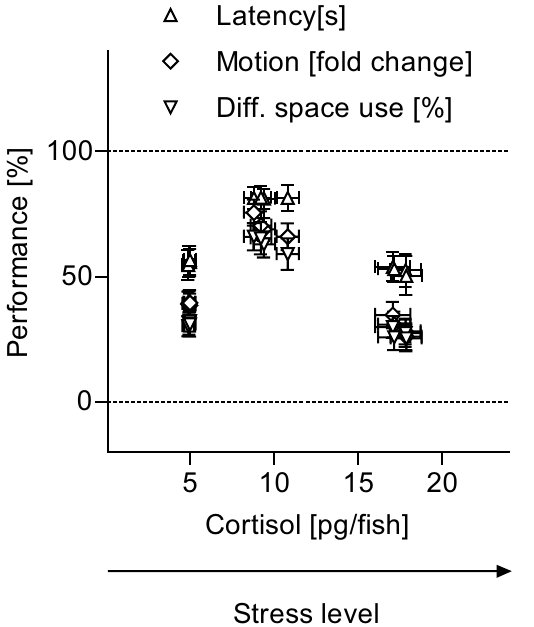
Figure 3. Performance as a function of stress level. Relative performance values (mean ± s.e.m., in %, as functions of min and max values) against whole-body cortisol for the data in Fig. 2D–F. Sample size per group,